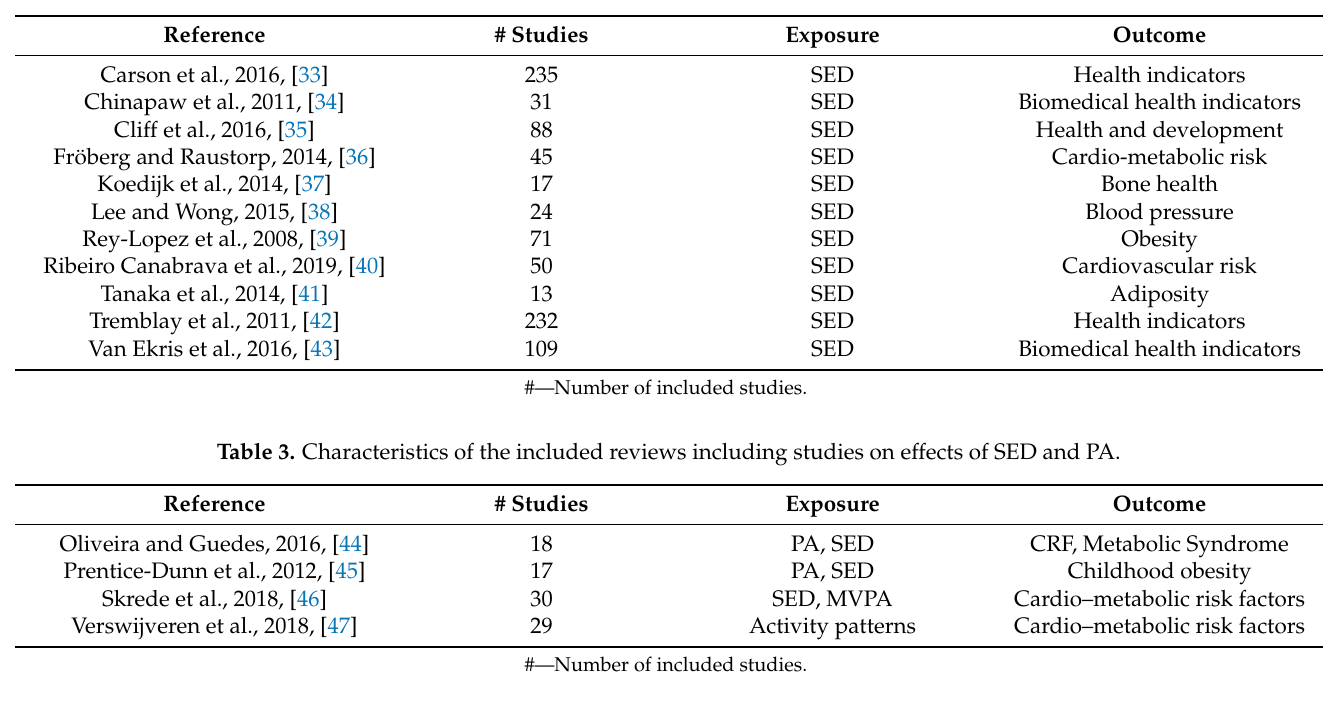
Table 2. Characteristics of the included reviews including studies on effects of SED.